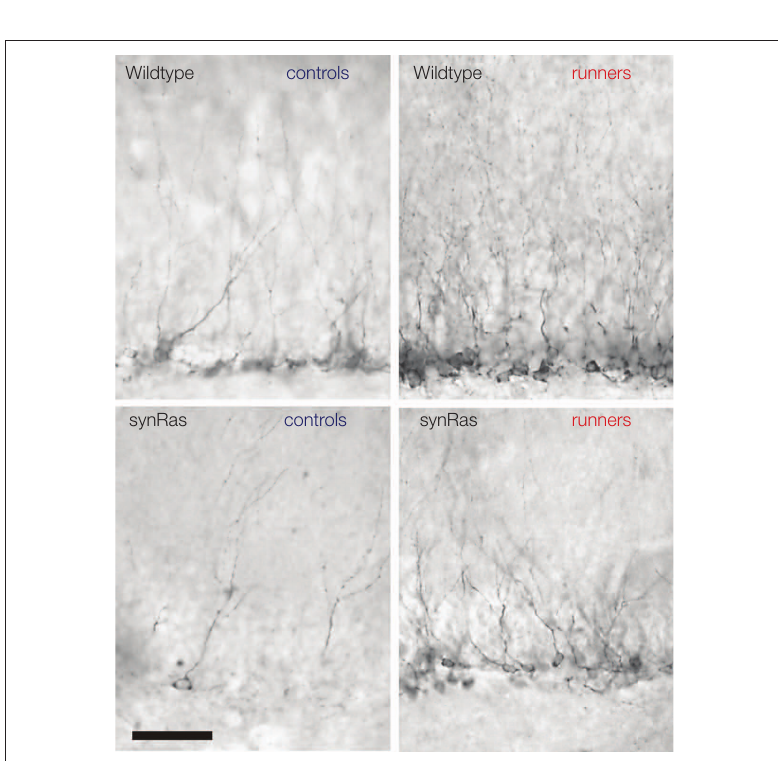
FigURe 2 | Physical activity could stimulate adult neurogenesis in the synRas mice. Doublecortin-labeled cells in the dentate gyrus of wildtype controls (upper left), wildtype runners (upper right), synRas controls (bottom left), and synRas runners (bottom